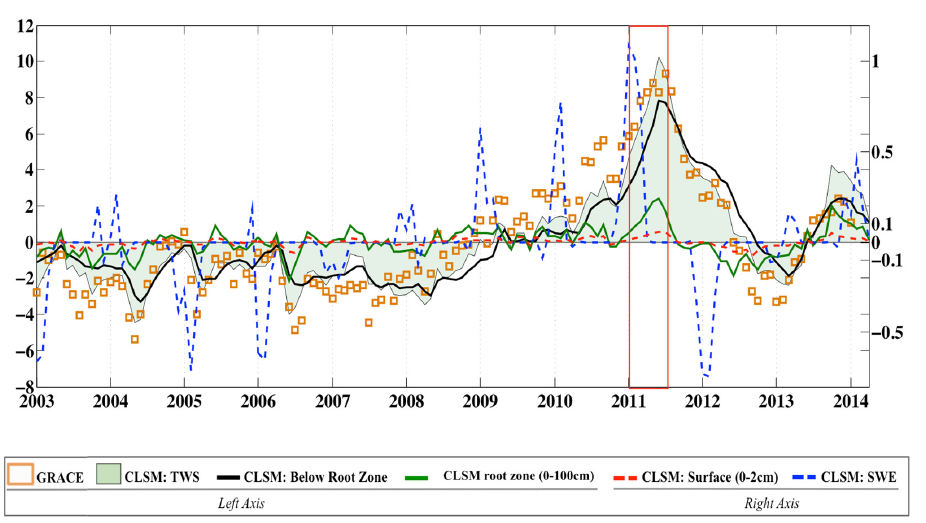
Figure 5. CLSM-DA disaggregated, residual terrestrial water storage time series ( i.e. , climatology removed) for the Northern Plains region. Time period is from January 2003–April 2014. Negative values designate deficits and positive surplus. Variables on the left axis are: CLSM-DA total water storage (green shading), Below RZMC or “groundwater” (black), RZMC (green), and monthly GRACE TWSA (gold squares). Variables on the right axis are: CLSM-DA SFMC (red dashed) and SWE (blue dashed). Units are centimeters of equivalent water